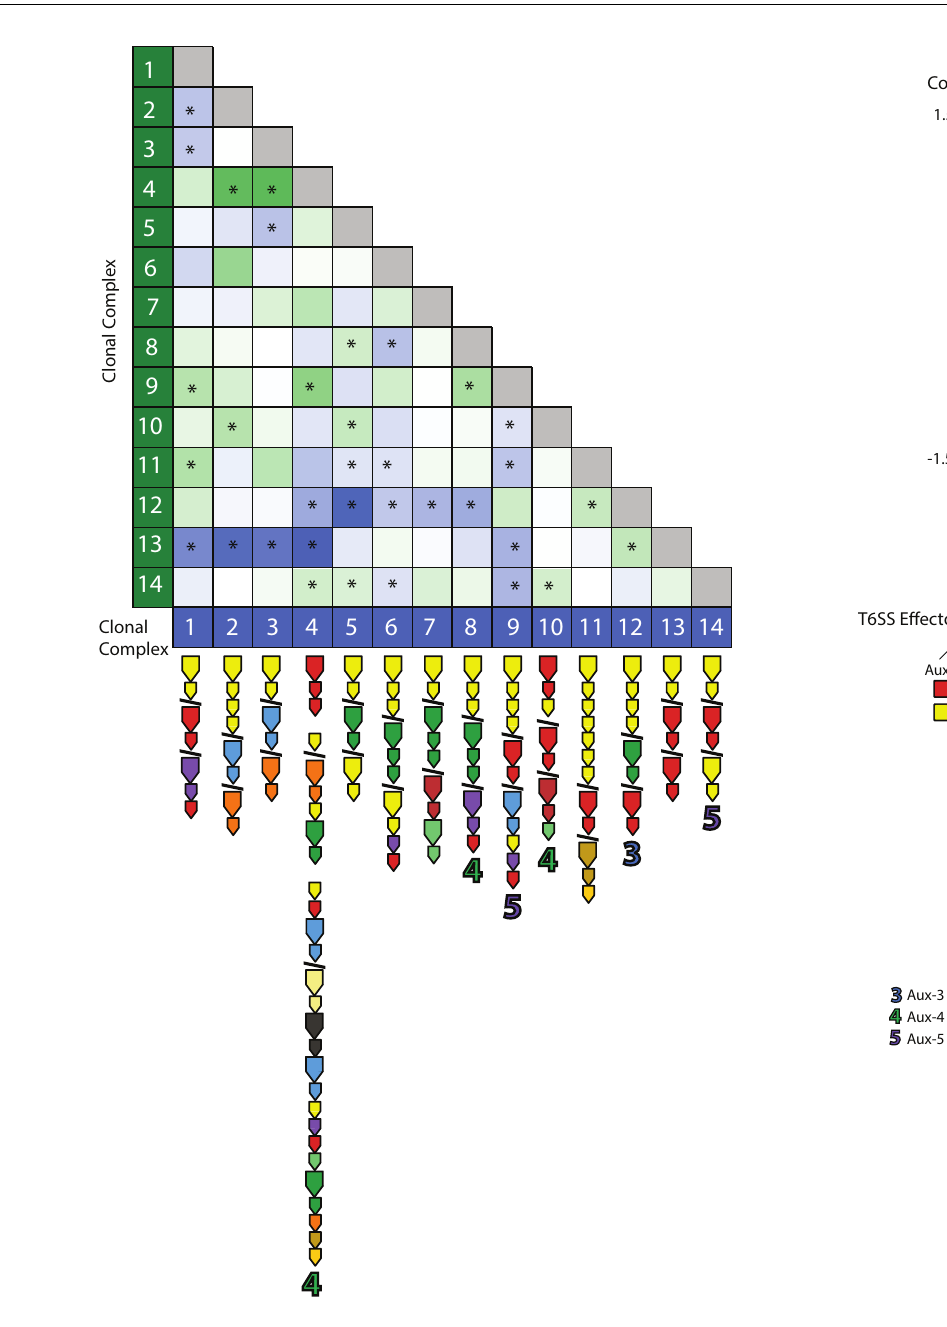
FIGURE 5 | Pairwise competition of members from an environmental Vibrio cholerae population. Strains were competed in equal concentration at 25 ◦ C over 4 h. The mean log competitive index was visualized for all competitions, and color and intensity within each cell indicate a favorable outcome for the strain listed on the left (green) or bottom (blue). E-I module composition is indicated below strain names. Asterisks (*) indicate statistically significant results from a two-tailed, one-sample Student’s t test ( p <